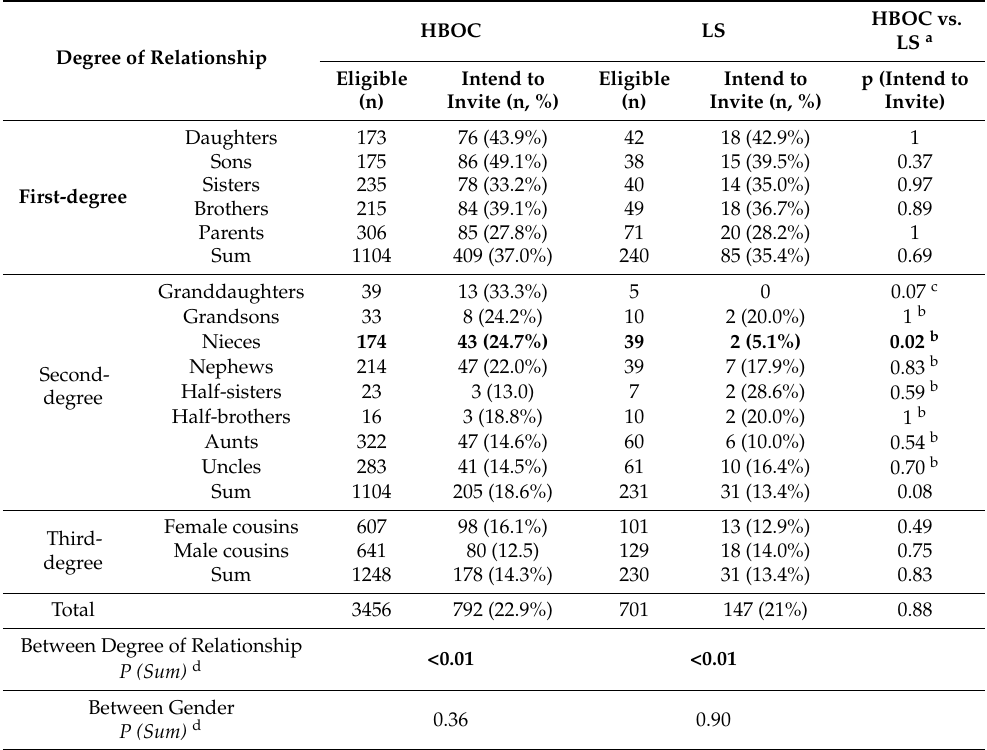
Table 2. Relatives potentially eligible for genetic testing versus proportion of relatives that respon- dents intend to invite by degree of relationship and